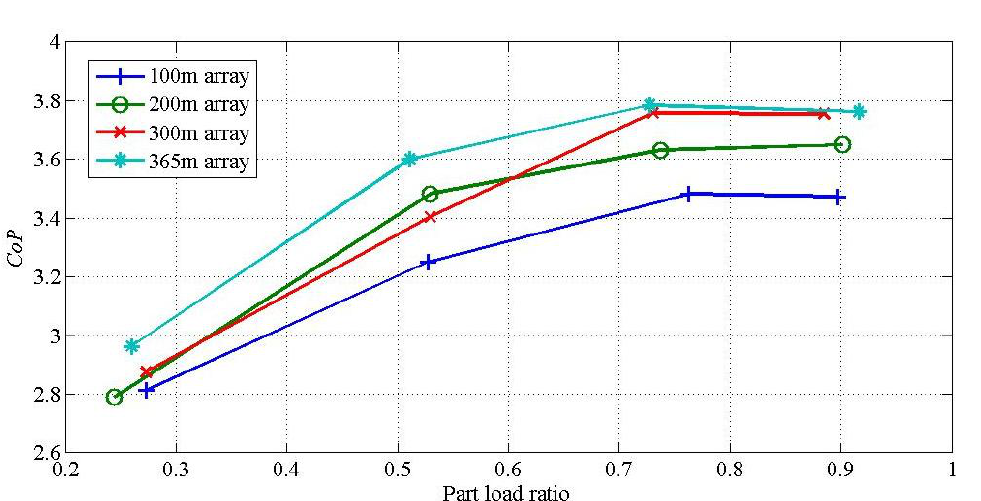
Figure 2. Part load performance results from the heat pump test